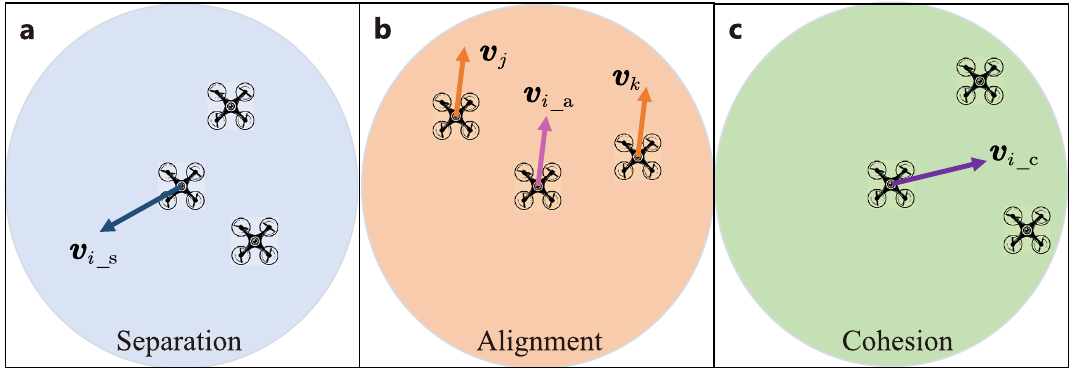
Fig. 2 Schematic diagram of the SAC rule interaction term. Different colors indicate different sizes of separation, alignment, and cohesion zone